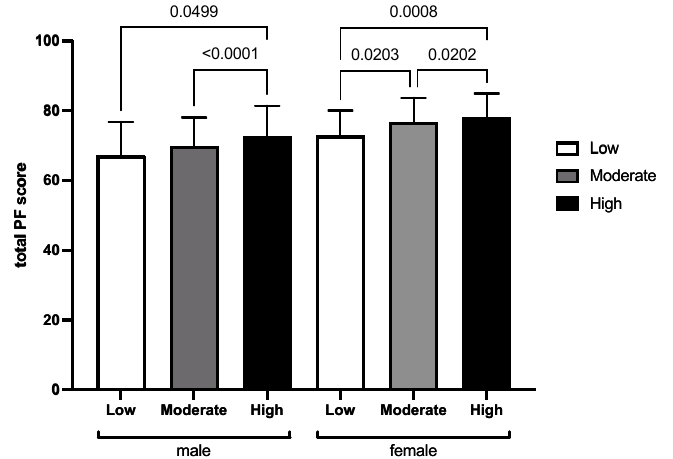
Figure 5. Mean and standard deviation of PF at different PA levels in males and females.